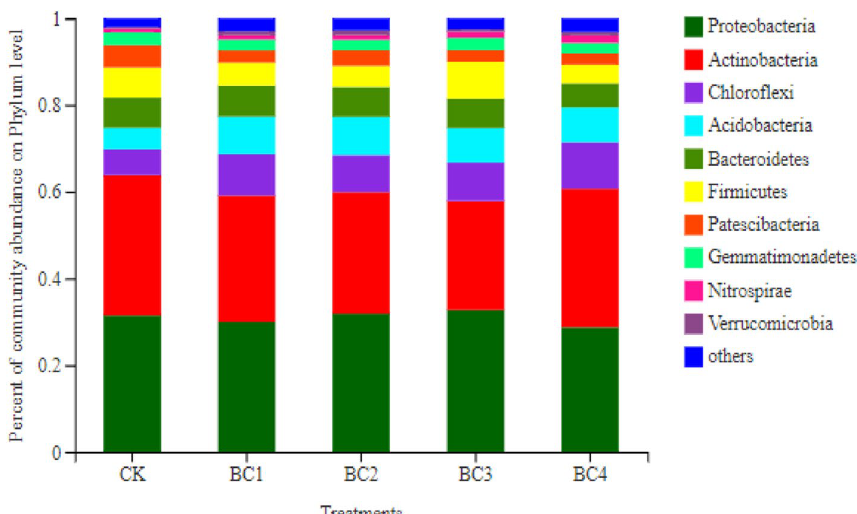
Fig. 2 Relative abundances and community compositions of the dominant bacterial phyla in soils from each biochar treatment (phylum level). Treatments CK, BC1, BC2, BC3, and BC4 had biochar dosages of 0%, 0.5%, 1%, 2%, and 4%